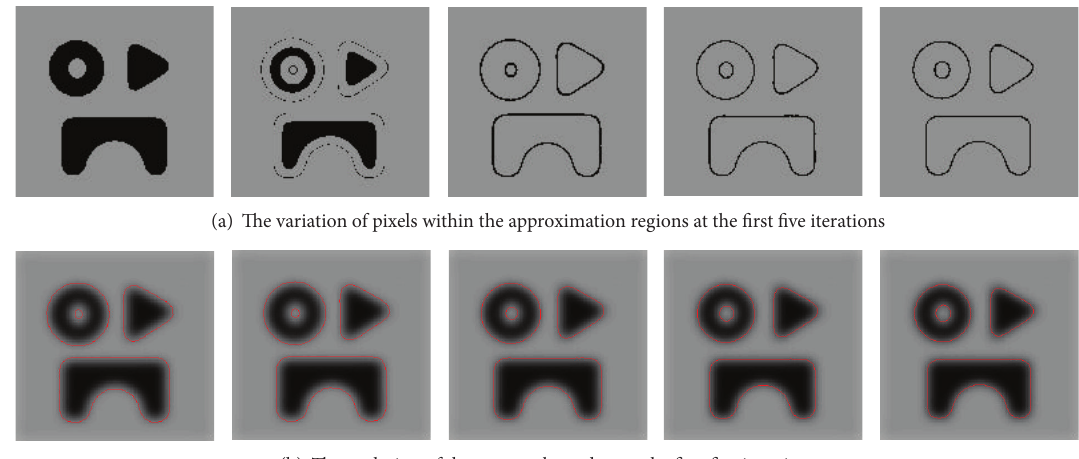
Figure 5: The evolution of the approximation region and the associated contour boundary with iteration.